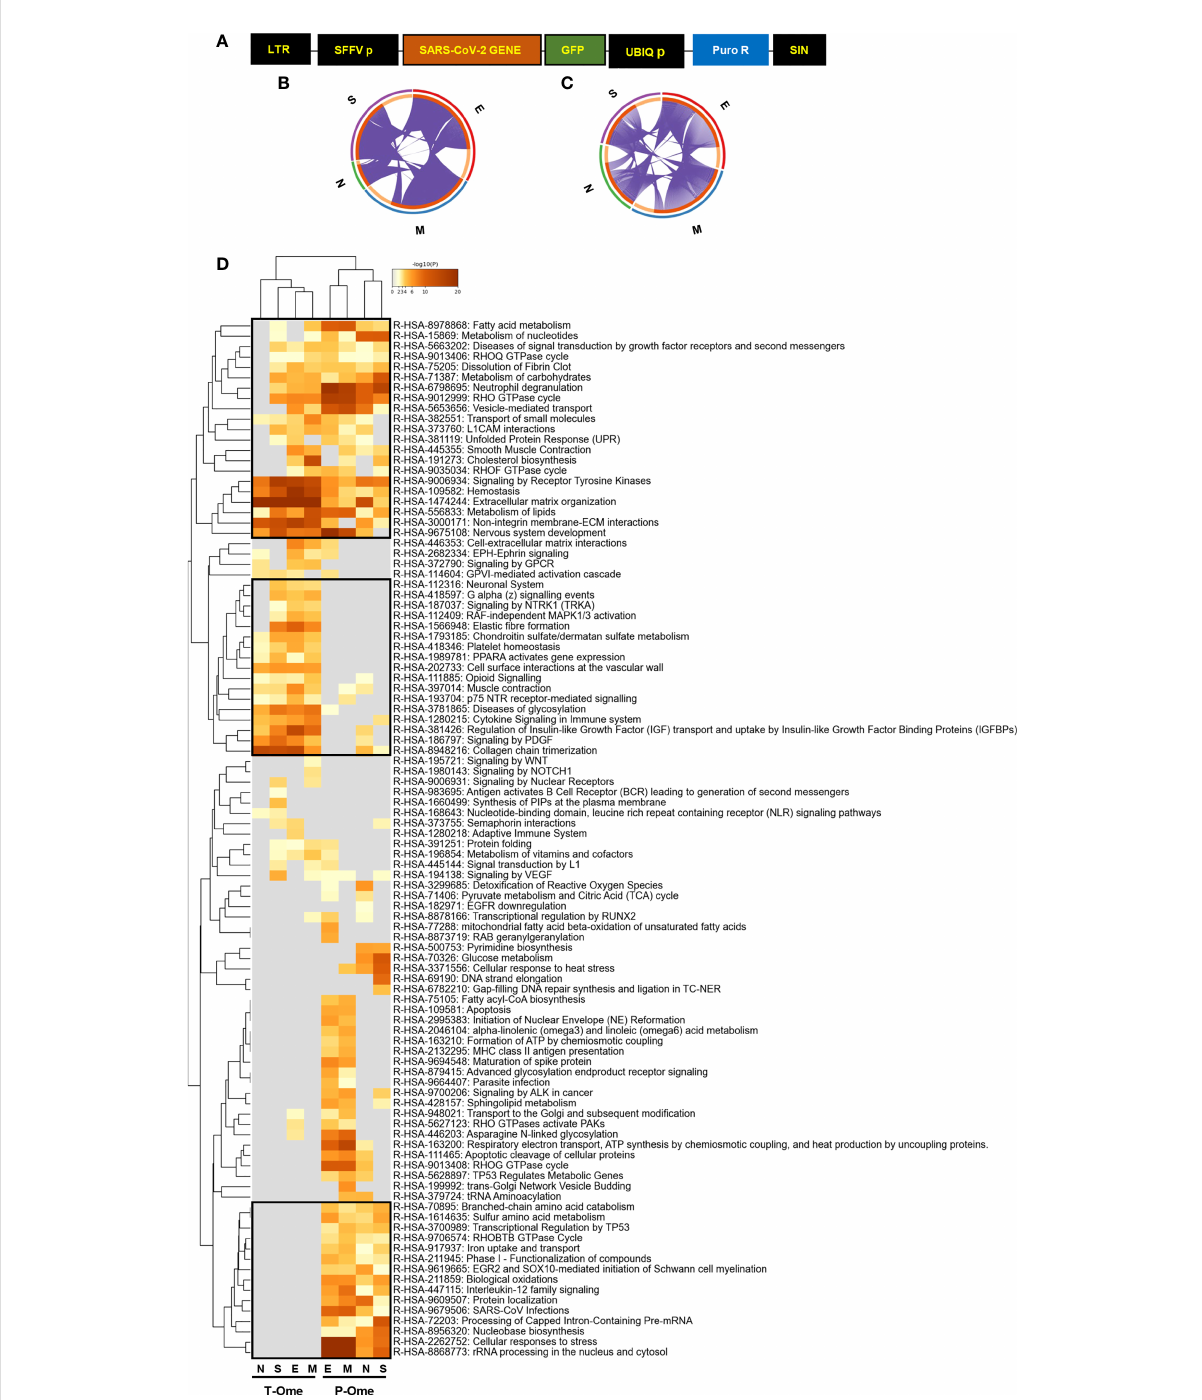
FIGURE 1 Molecular dyshomeostasis induced by SARS-CoV-2 structural proteins in OBC1 cells. (A) Lentivector expression vectors used in this study. LTR, long terminal repeats; SFFV, spleen focus-forming virus promoter; GFP-tagged SARS-CoV-2 structural proteins (M, N, E, S); UBIQp, ubiquitin promoter; PuroR, gene conferring puromycin resistance. (B, C) Circus plot of dysregulated transcripts (B) and proteins (C) targeted by each SARS-CoV-2 structural proteins. Purple lines indicate the common deregulated transcriptome/proteome across OBC1 cells that express each GFP-tagged SARS-CoV-2 structural protein. (D) Functional clustering representing the signi fi cantly altered pathways by SARS-CoV-2 structural proteins at the transcriptome (T-Ome) and proteome (P-Ome) layers. The heat map cells are coloured by their p values; white cells indicate the lack of enrichment for that term in the corresponding protein/gene list. Squares (black frame) highlight signi fi cantly enriched terms detected at transcript, protein levels or